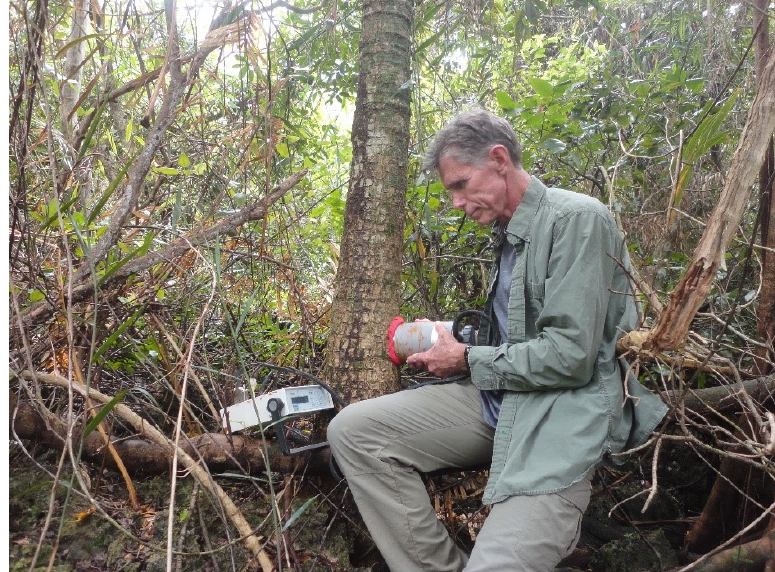
Figure 5. Depiction of the infrared gas exchange instrument (left) and chamber in use near the base of a Cycas stem with red malleable modeling clay used for seal.